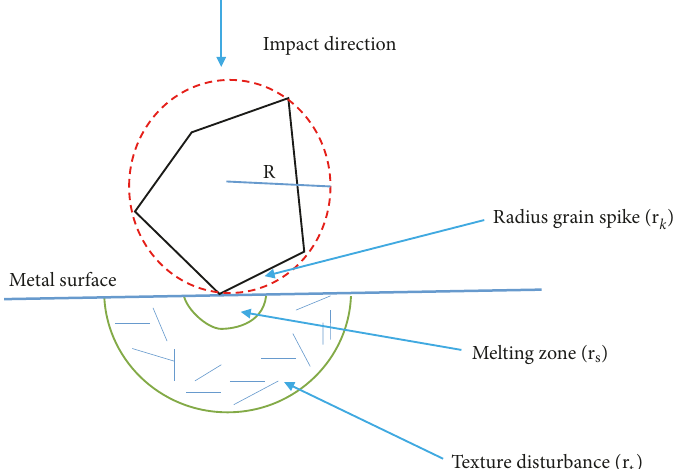
Figure 5: Variations of a metal surface at the impact point of a grain during sandblasting process. R: radius grain; r k : radius grain spike; r s : radius melting zone; r t : radius texture disturbance